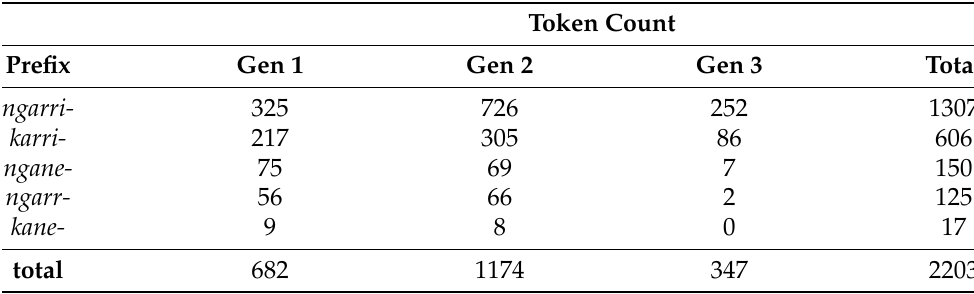
Table 8. Count of first person plural prefixes across three generations. Gen 1: 1907–1944, Gen 2: 1945–1976, Gen 3: